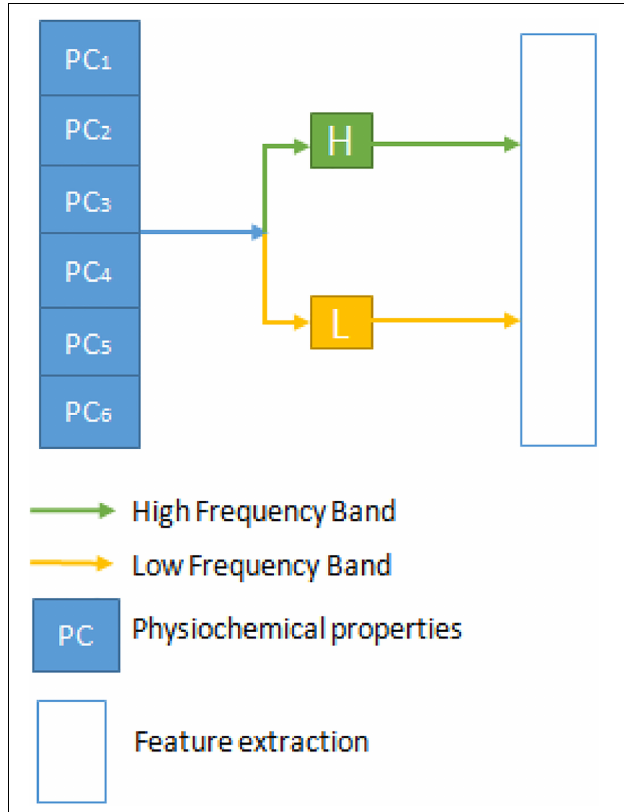
FIGURE 1 | The discrete wavelet transform